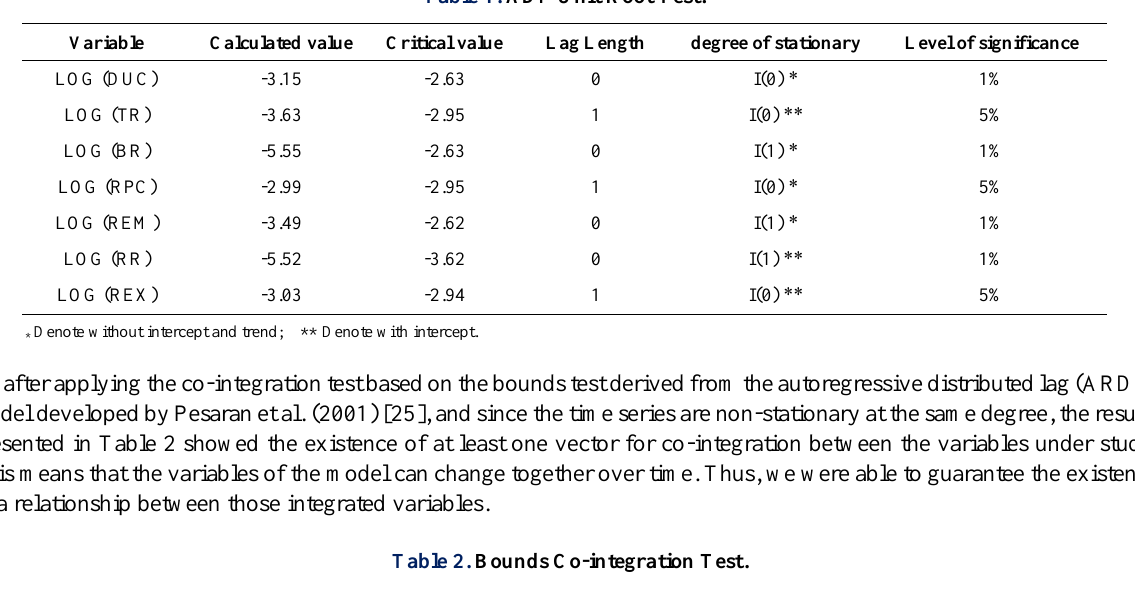
Table 1. ADF Unit Root Test.